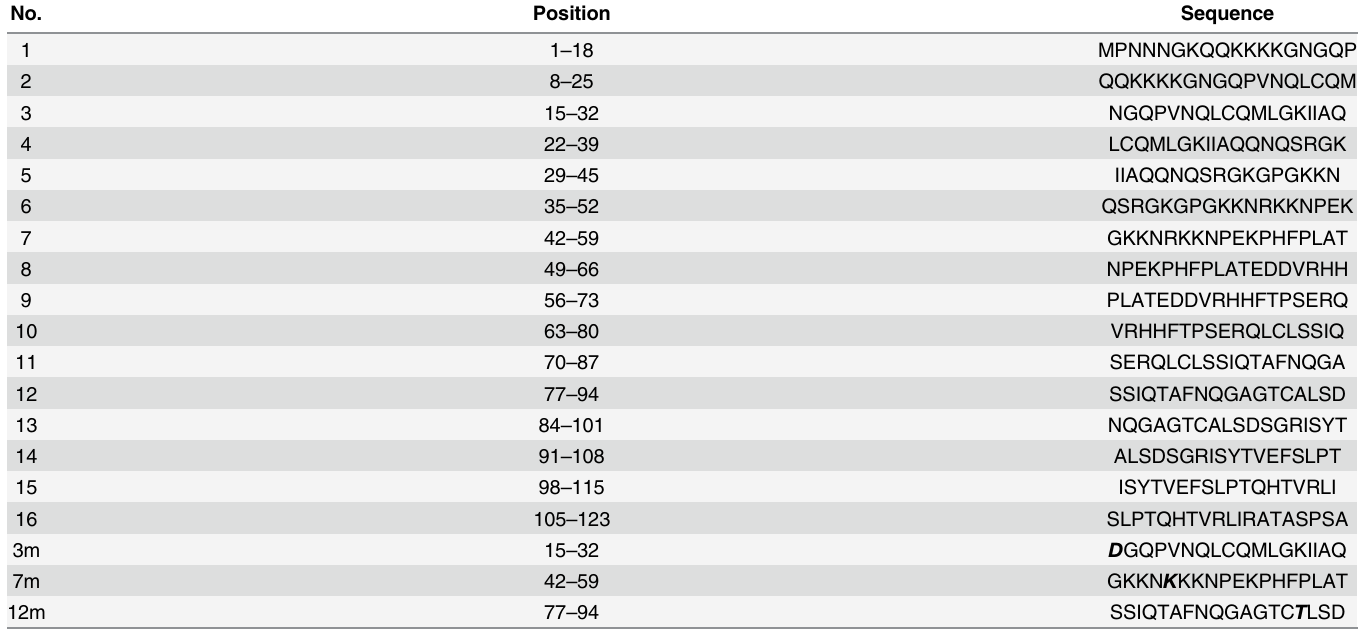
Table 1. Synthetic peptides used in this